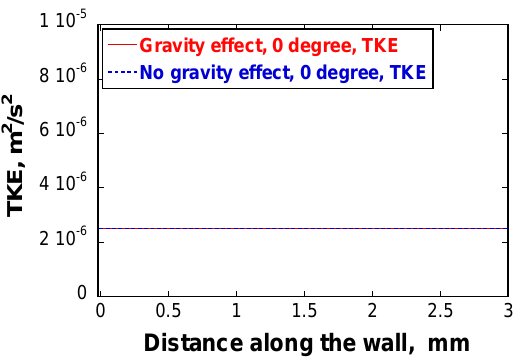
Figure 11. Comparison of TKE along the straight central part of the test tube with and without a gravity effect.